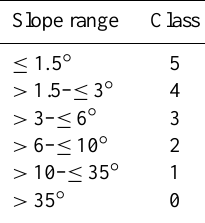
Table 1. Slope classes.